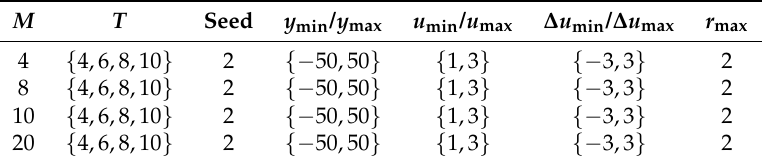
Table 1. Problem data related to Table 3